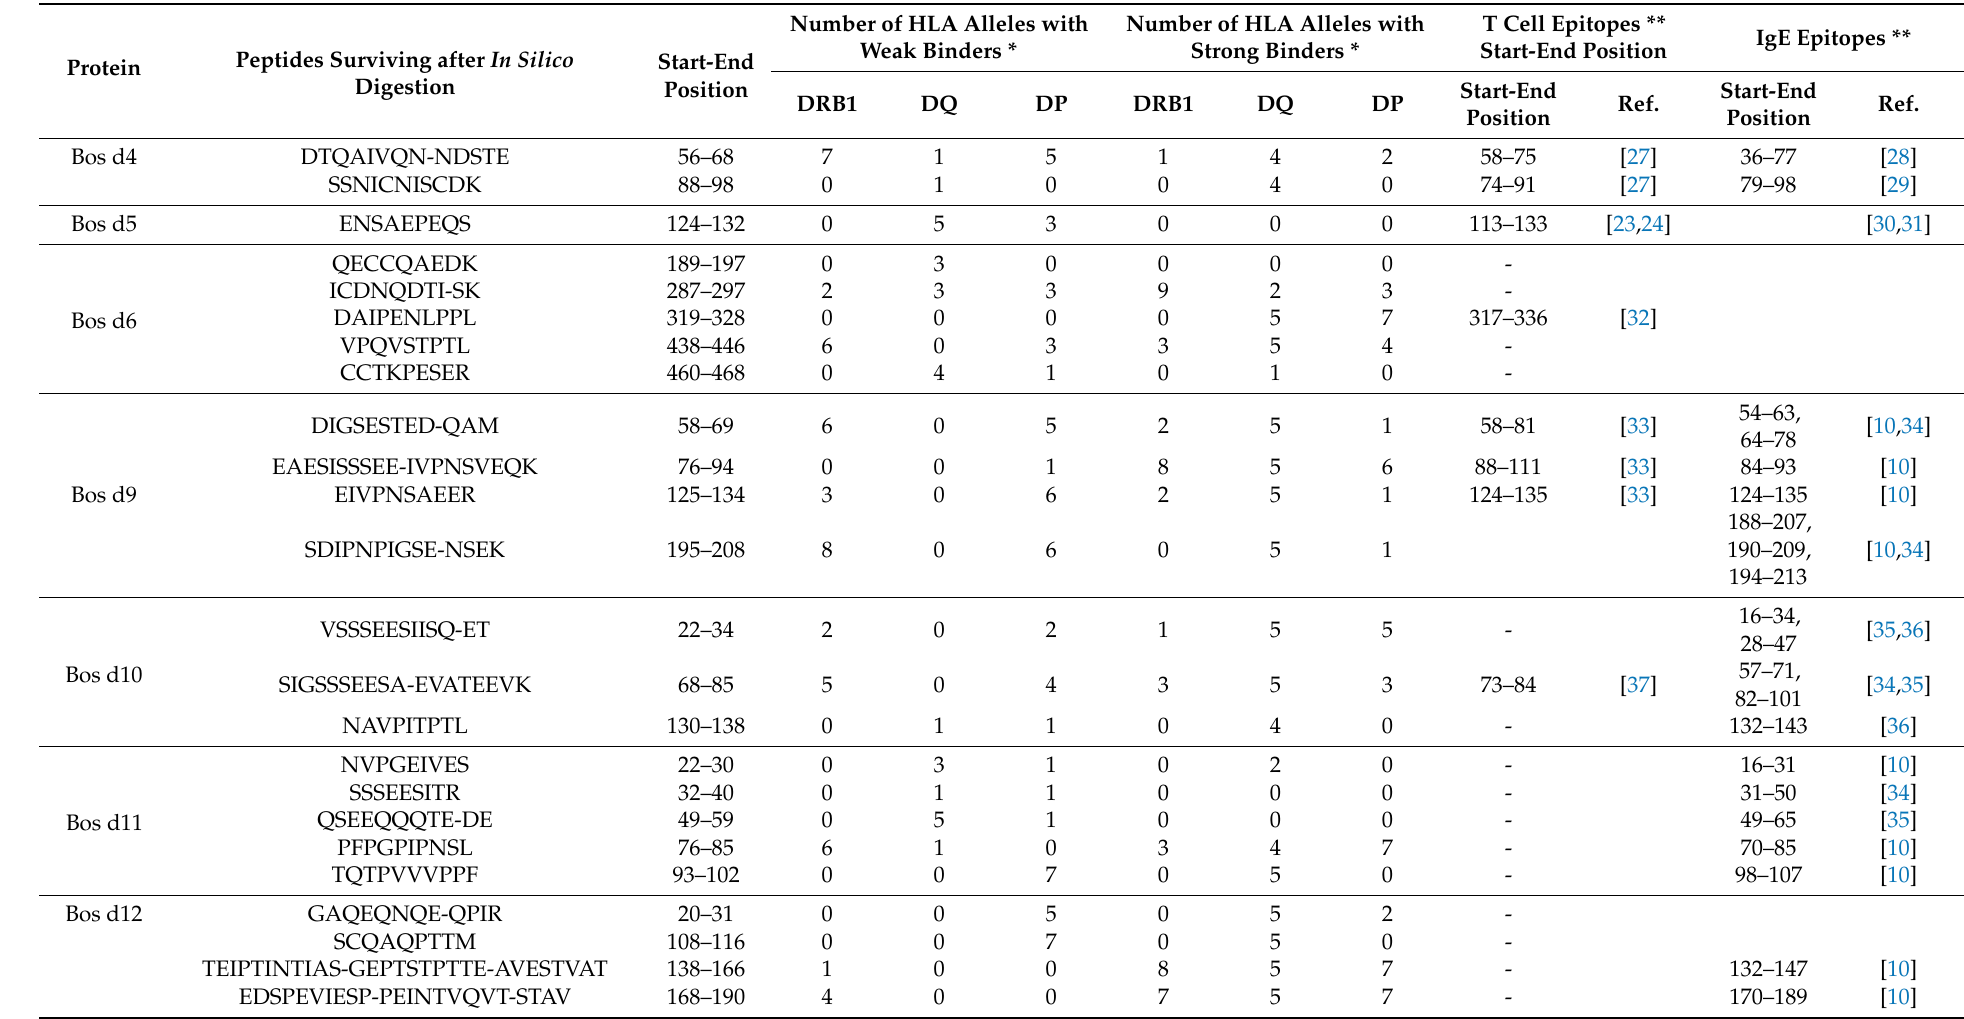
Table 1. In silico antigenicity assessment of in silico digested peptides with major MHC II alleles according the EpiTOP3